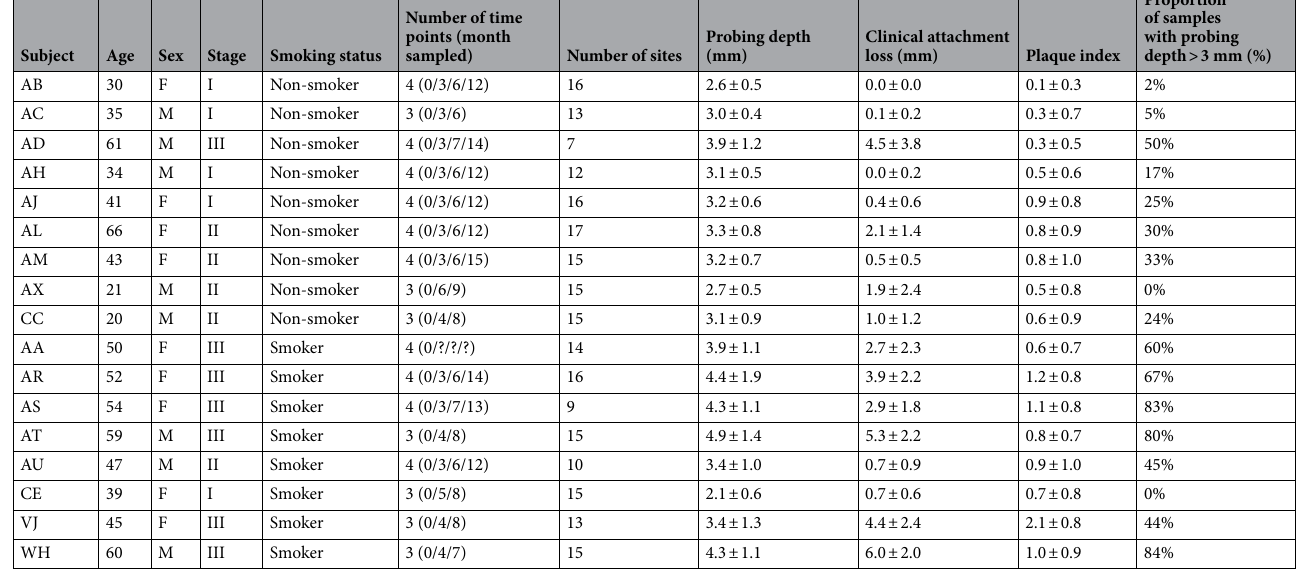
Table 1. Baseline characteristics of study participants. The months when samples were taken are shown in parenthesis separated by slashes. For clinical measurements, mean ± standard deviation is